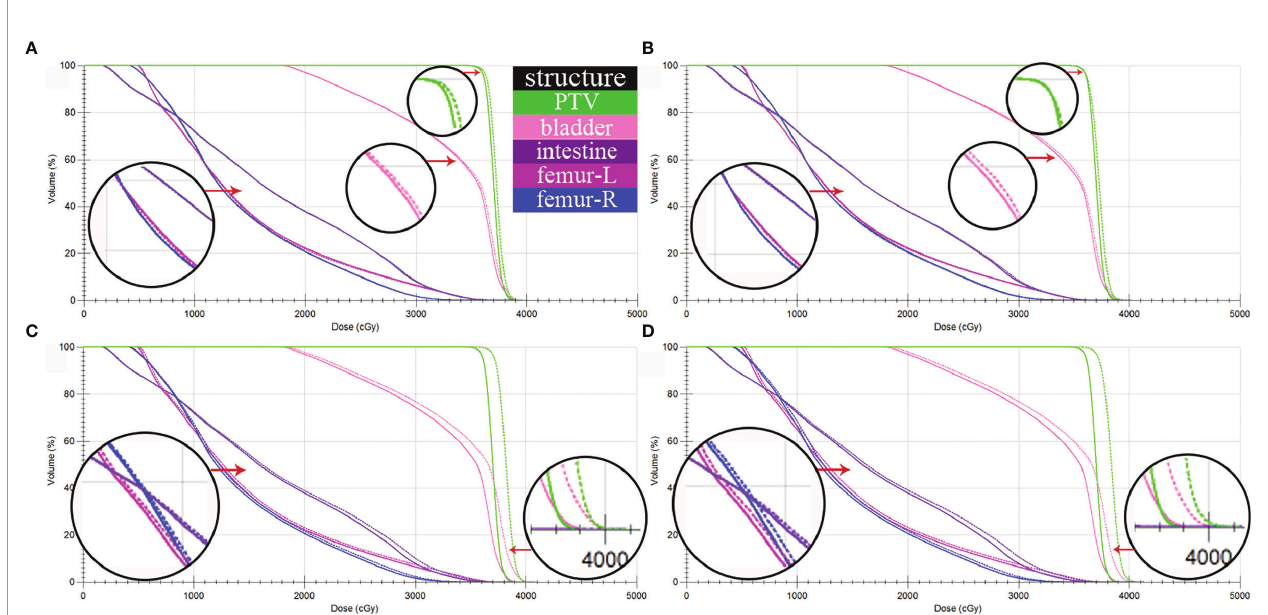
FIGURE 9 | DVH comparison between CT gt and pseudo CT obtained by three different deep learning methods. (A) DVH difference between CT gt and CT CycleGAN . (B) DVH difference between CT gt and CT unet-GAN . (C) DVH difference between CT gt and CT FCN-GAN . (D) DVH difference between CTgt and CBCT. The solid line is the dose line of CT gt . The dotted line is the dose line of CT gt or CBCT.